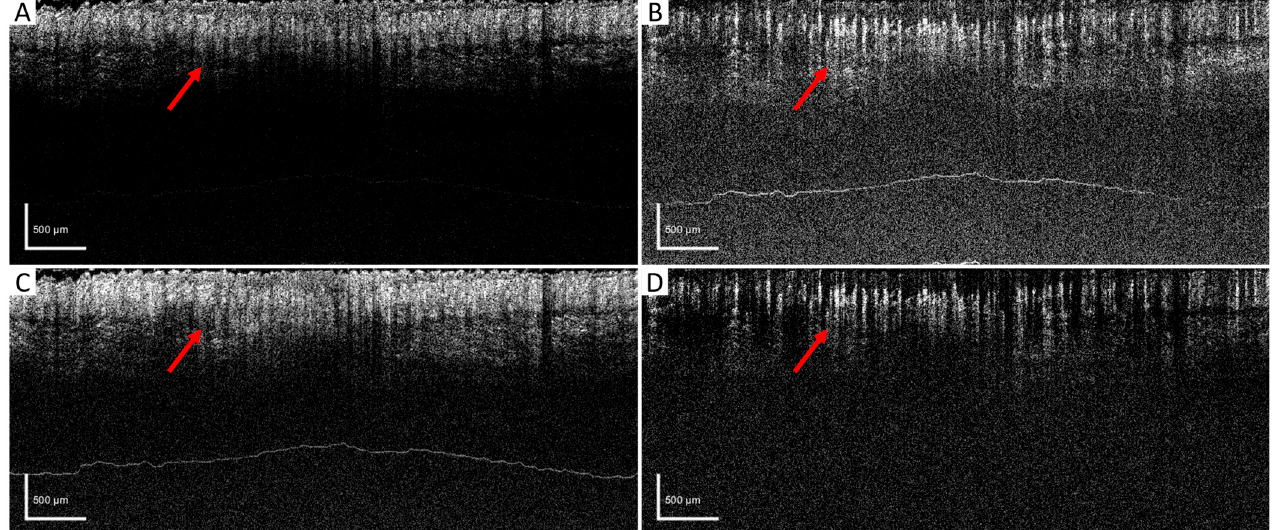
Figure 4. B-scan comparison. The same B-scan frame with 4 repeating times was processed by ( A ) SV, ( B ) aED, ( C ) bED, and ( D ) wED, respectively. Regions that have differences in OCTA reconstruction were pointed out with red arrows. SV: Speckle Variance; aED: A-scan eigen-decomposition; bED: B-scan eigen-decomposition; wED: windowed eigen-decomposition.